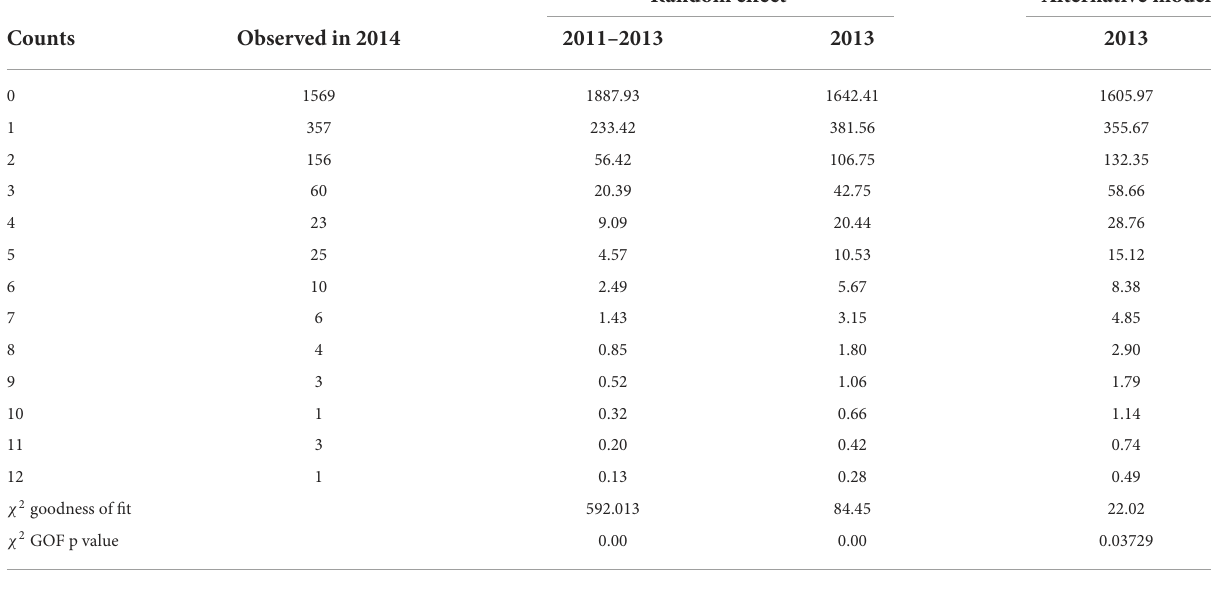
TABLE 5 Expected frequency for the year 2014 based on two frequency models for training data